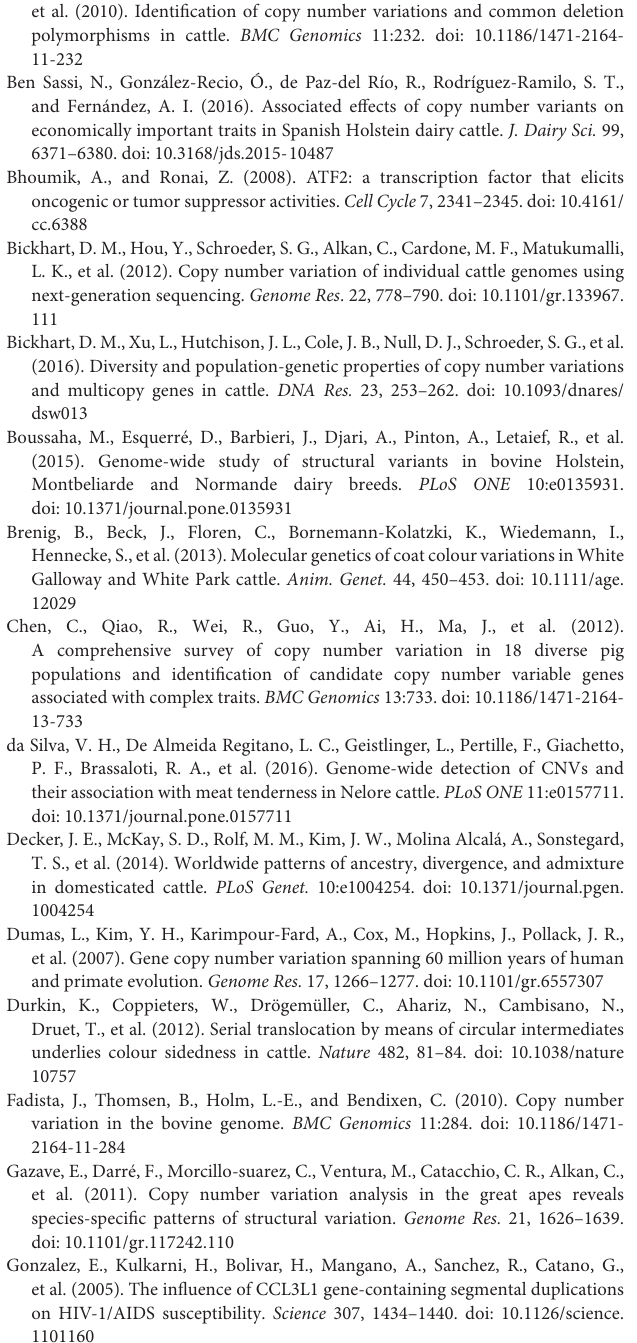
TABLE S10 | Detail about gene ontology category significantly overrepresented in CNVR. TABLE S11 | List of all unique CNVRs which are identified only in the present study (after comparing with the previous